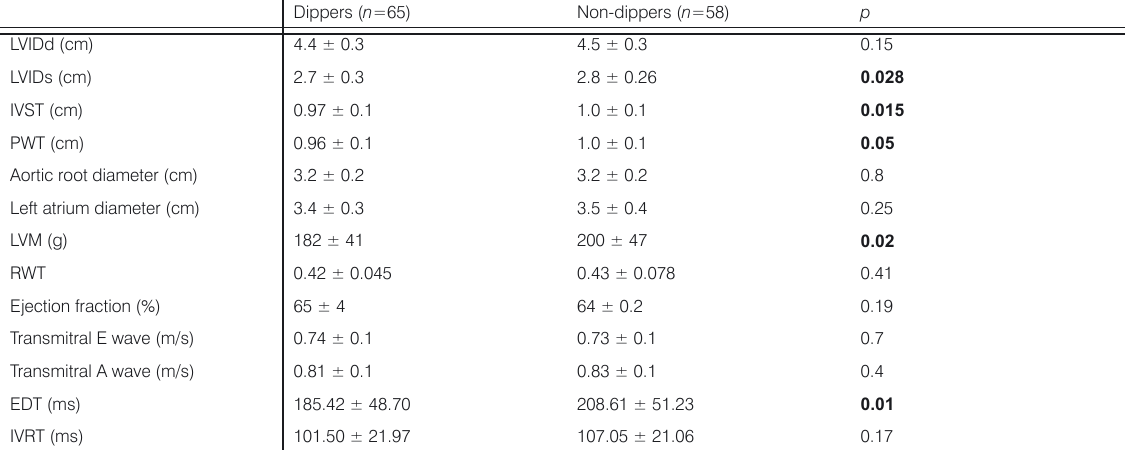
Table 2. Echocardiographic data in dippers, non-dippers.